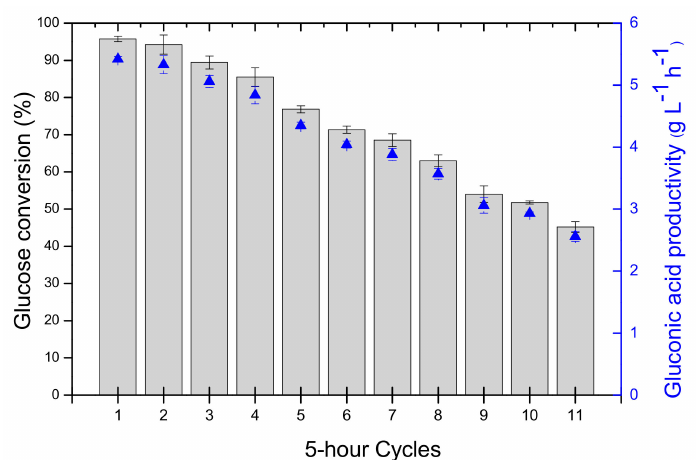
Figure 2. Reuse assays of gluconic acid production from 26 g L − 1 glucose solution (0.1 L) catalyzed by the GOD / CAT combi-CLEAs (105 and 12 mg of GOD and CAT in the combi-CLEA, corresponding to 7336.15 and 57433.85 U / g glucose, respectively) in a bubble column reactor kept at constant 40 ◦ C and pH 6.0. Values are expressed as mean of duplicate assays ± s.d. Table 2. Productivity of gluconic acid catalyzed by GOD / CAT immobilized using di ff erent methods. Immobilized Catalyst Bioreactor